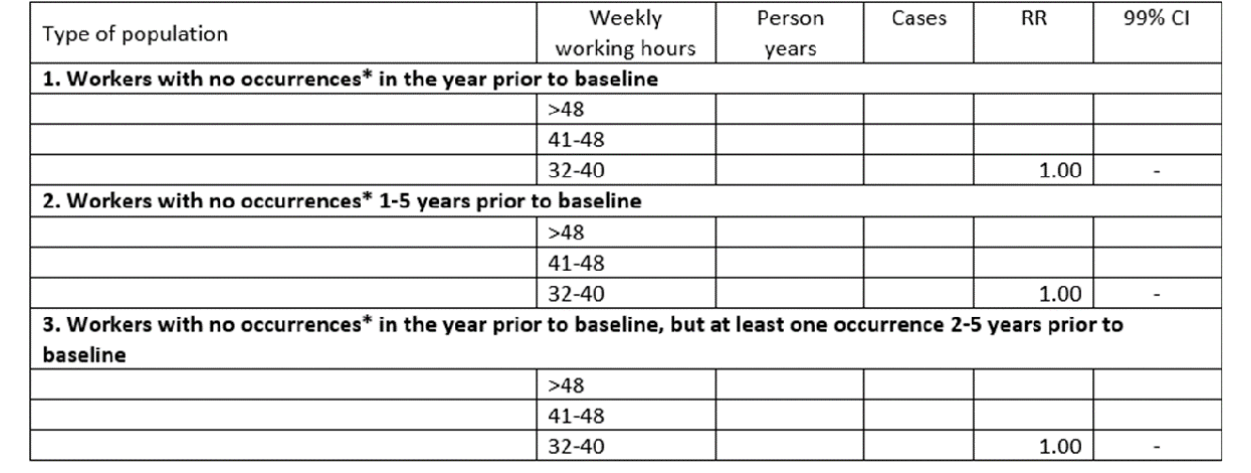
Figure 9. Dummy table: rate ratios (RRs) with 99% CIs for incident or recurrent use of psychotropic drugs, as a function of weekly working hours among employees in Denmark 2004-2013. Populations 2 and 3 are disjointed and exhaustive subsets of population 1. *The term occurrences refers to “occurrences of redeemed prescriptions for psychotropic medicine or psychiatric hospital